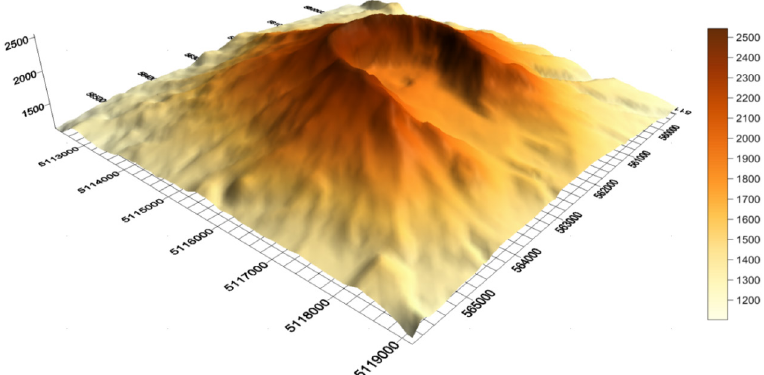
Figure 8. The 3D surface of volcano Saint Helena (Dimension in